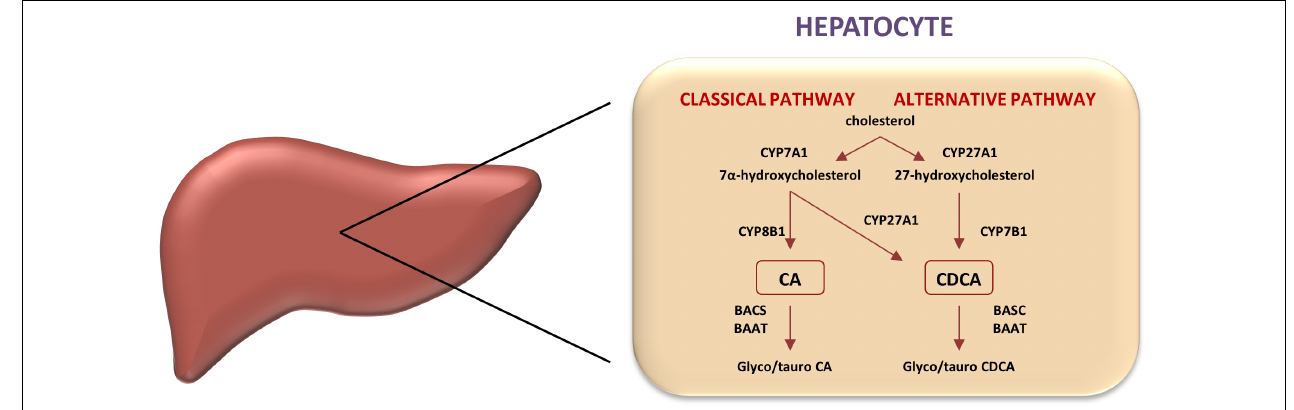
FIGURE 1 | Classic and alternative pathways of bile acids synthesis. In human liver, two primary bile acids, cholic acid (CA), and chenodeoxycholic acid (CDCA), are produced. Key regulatory enzymes in both pathways are shown. Microsomal cholesterol 7 α -hydroxylase (CYP7A1) catalyzes the first the rate-limiting step in the classic pathway converting cholesterol into 7-hydroxycholesterol, whereas the mitochondrial sterol 27-hydroxylase (CYP27A1) initiates the alternative pathway by converting cholesterol into 27-hydroxycholesterol, which is then 7-hydroxylated by microsomal oxysterol 7-hydroxylase (CYP7B1). CYP8B1 regulates the cholic acid synthesis in the classic